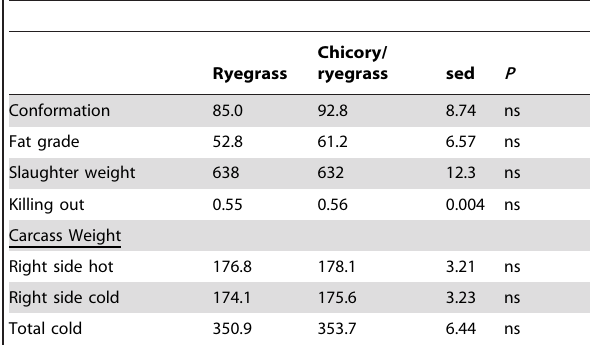
Table 5. Carcass characteristics of beef steers ( n =36) grazing either chicory/ryegrass or ryegrass